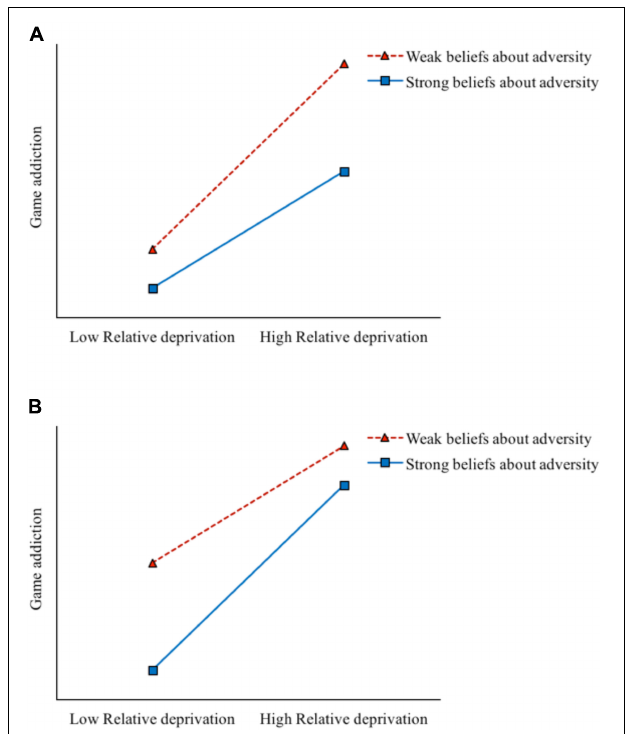
FIGURE 1 | Two different moderating models of beliefs about adversity on the relation between relative deprivation and left-behind children’s game addiction. (A) Risk-buffering model. (B) Reverse risk-buffering